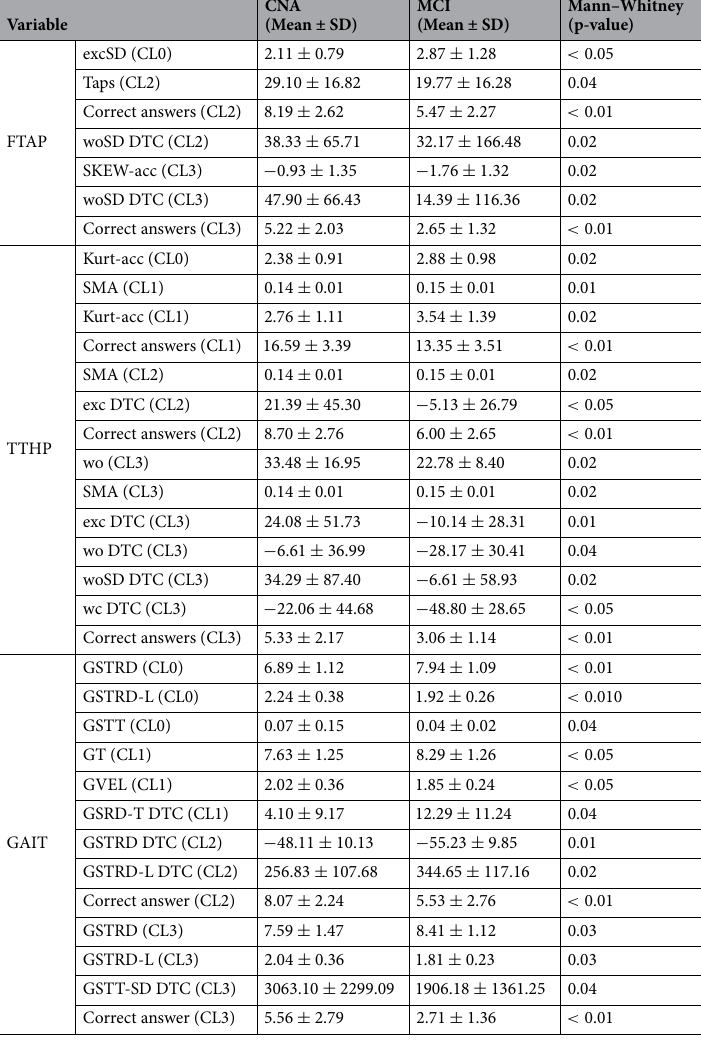
Table 3. FTAP, TTHP and GAIT parameters that significantly differs between CNA and MCI subjects. The complete list of parameters extracted and evaluated is encompassed in the Supplementary Material.